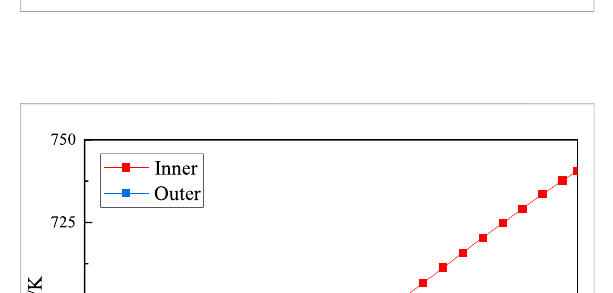
FIGURE 12 Distribution of temperature of the thermal stress model.